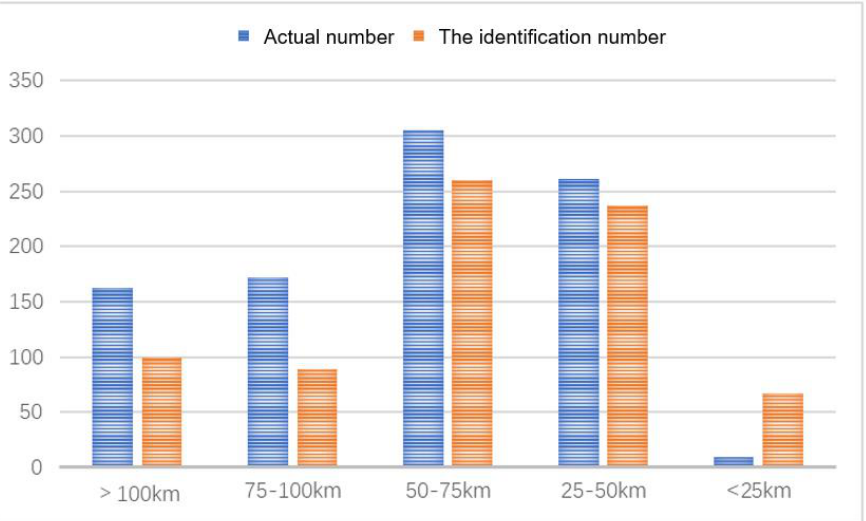
Figure 13. Comparison diagram of the actual number of anomalies (impact crater) classified by diameter and the number of anomalies identified by U-net.